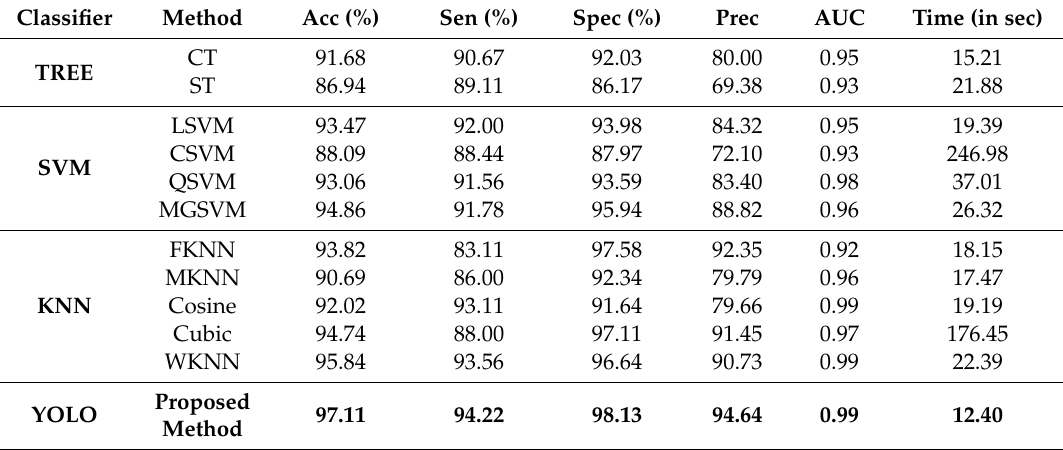
Table 14. Comparative study between proposed classifier and well-known classifiers on ISIC 2019 dataset.